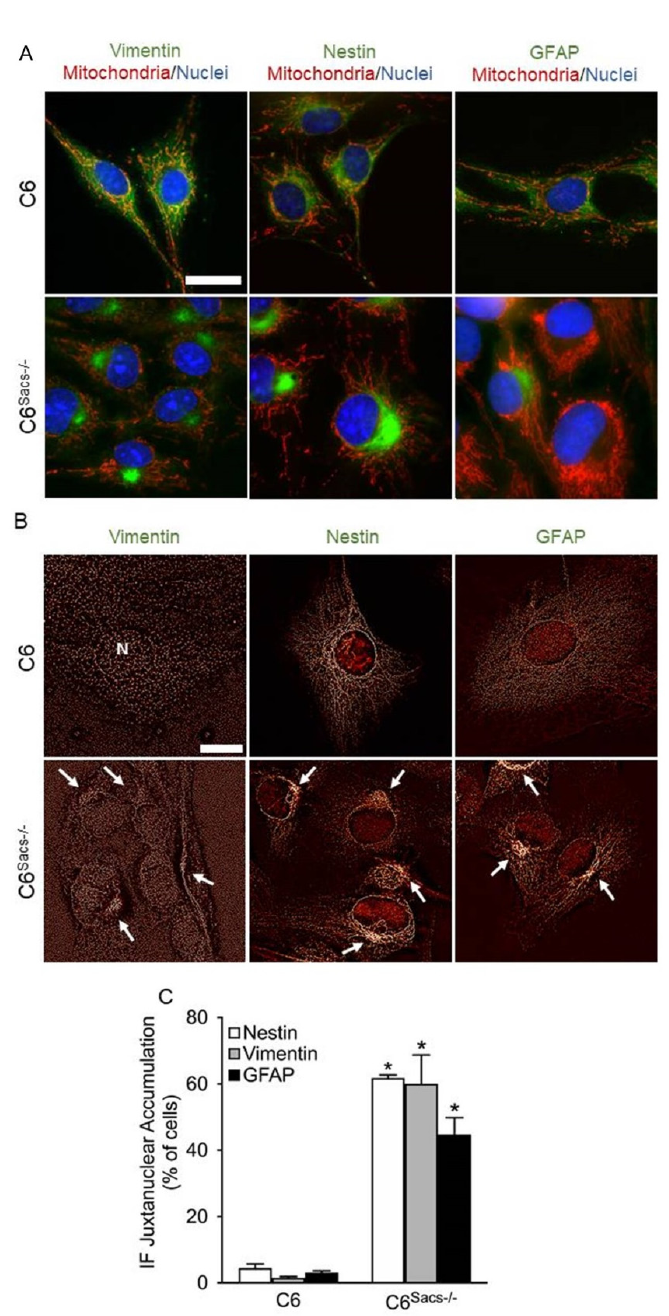
Figure 3. Sacsin deletion disrupts glial intermediate filament networks. ( A ) Representative im ‐ munocytochemistry images showing the distribution of the glial intermediate filaments vimentin, nestin and GFAP (green); mitochondria (Mitotracker, red); and nuclei (Hoechst, blue) in C6 and C6 Sacs − / − cells. Vimentin, nestin and GFAP accumulate in the juxtanuclear area in C6 Sacs − / − cells. Scale bar, 20 μ m. ( B ) Widefield images of C6 and C6 Sacs − / − cells were further analyzed by means of the Nano J Super ‐ Resolution Radial Fluctuations (SRRF) algorithm, which provided higher resolution details to obtain a more defined image of the intermediate filament networks. N, nucleus. White arrows, intermediate filament aggregates. Scale bar, 20 μ m. ( C ) Quantification of microscopy im ‐ ages from 3 independent experiments (mean ± SEM). *, significant vs. C6 reference strain ( p < 0.05, Student’s t ‐ test). The total numbers of reference C6 cells counted in 3 independent experiments were 549 (GFAP), 464 (Nestin) and 353 (Vimentin). The total numbers of C6 Sacs − / − cells counted in 3 independent experiments were 836 (GFAP), 697 (Nestin) and 438 (Vimentin).